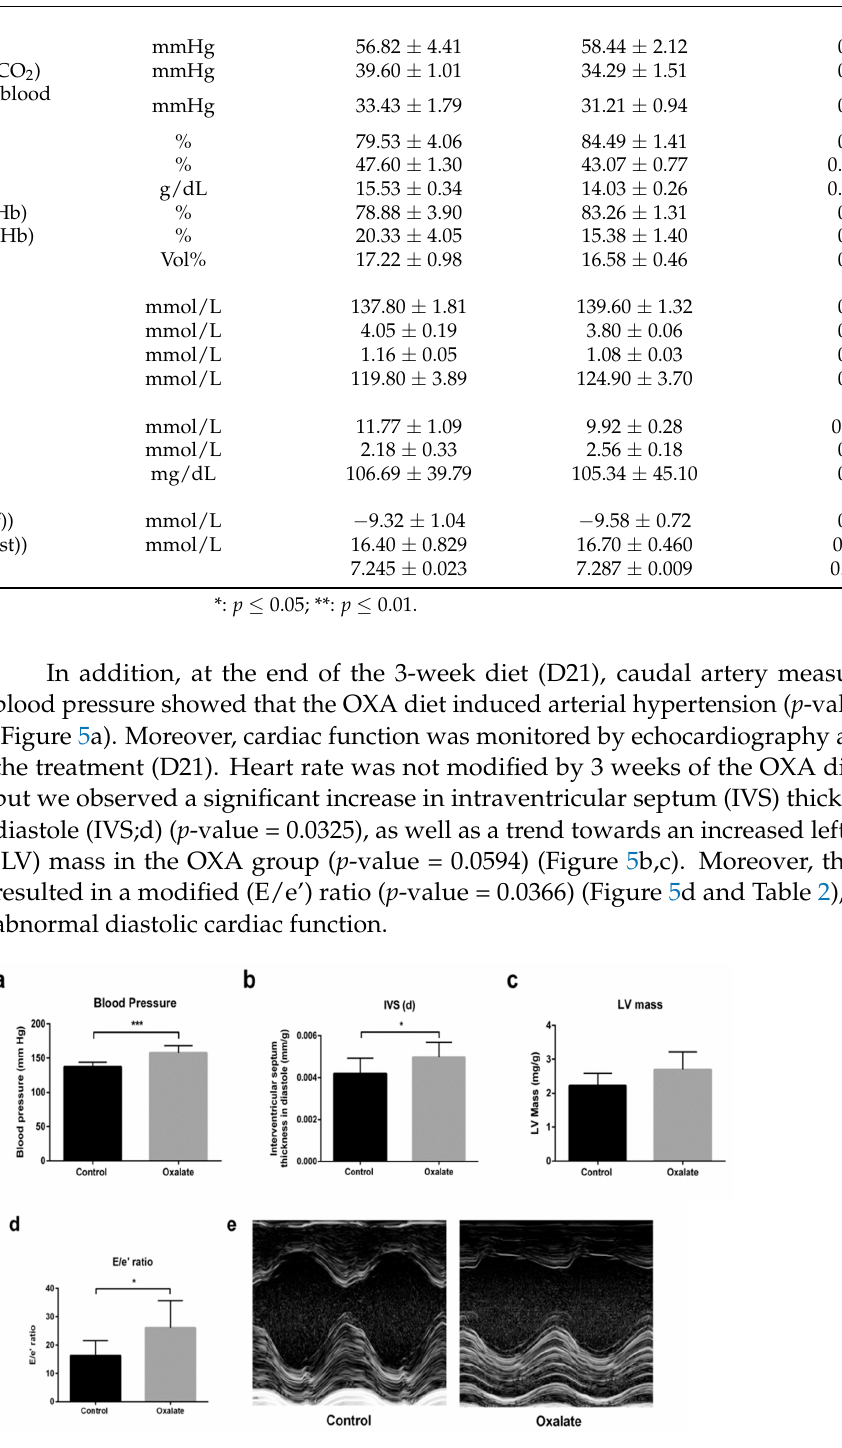
Figure 5. Impact of 3 weeks of an OXA diet on blood pressure and cardiac function: ( a ) blood pressure (mmHg); ( b ) IVS;d (mm/kg)—intraventricular diastolic septum thickness; ( c ): LV mass (mg/kg)—left ventricular mass; ( d ) E/e’ ratio; ( e ) representative images in both experimental groups at parasternal short axis view of the LV with M-mode. Results are expressed as mean ± SD. * p ≤ 0.05; *** p ≤ 0.001. Control n = 5, oxalate n = 27. Table 2. Echocardiographic parameter analysis after 3 weeks of OXA diet (results are expressed as mean ± SD. Control n = 5, oxalate n = 27). Unit